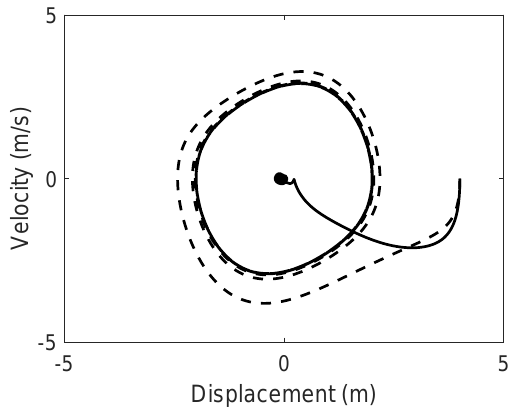
Figure 5. Uncontrolled state-space trajectory (dashed line) and feedforward controlled state-space trajectory (solid